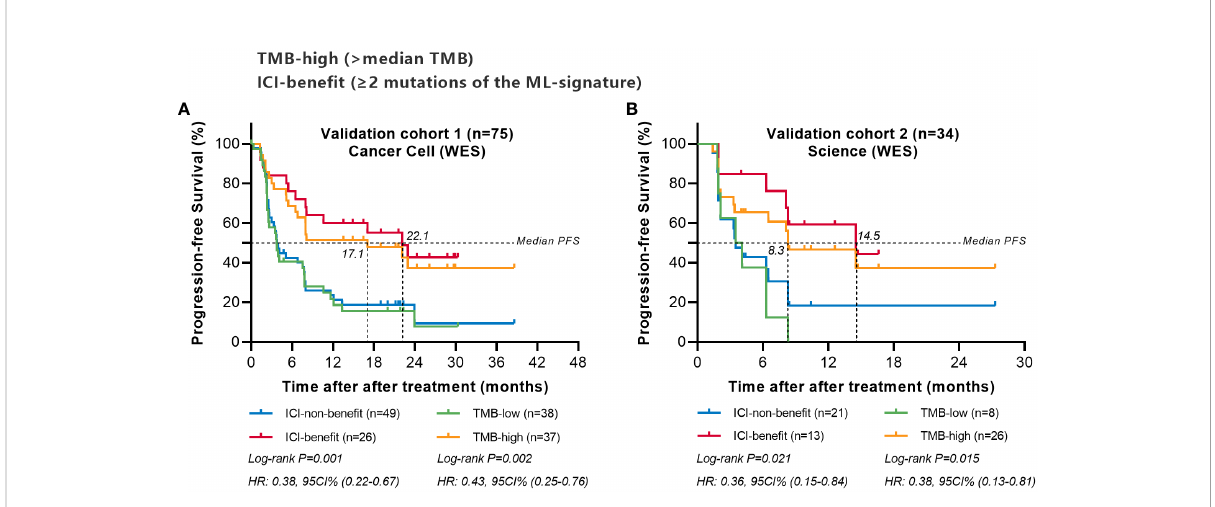
FIGURE 6 Comparing the predictive powers of ML-signature vs. TMB in patients treated with immunotherapy in external cohorts. (A) Cancer cell (WES) validation cohort, (B) Science (WES) validation